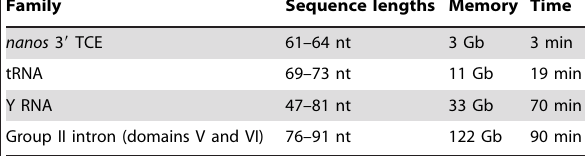
Table 7. Estimates of the memory and time required to reconstruct ancestral structures of three RNAs from several families of biological interest (as reported by